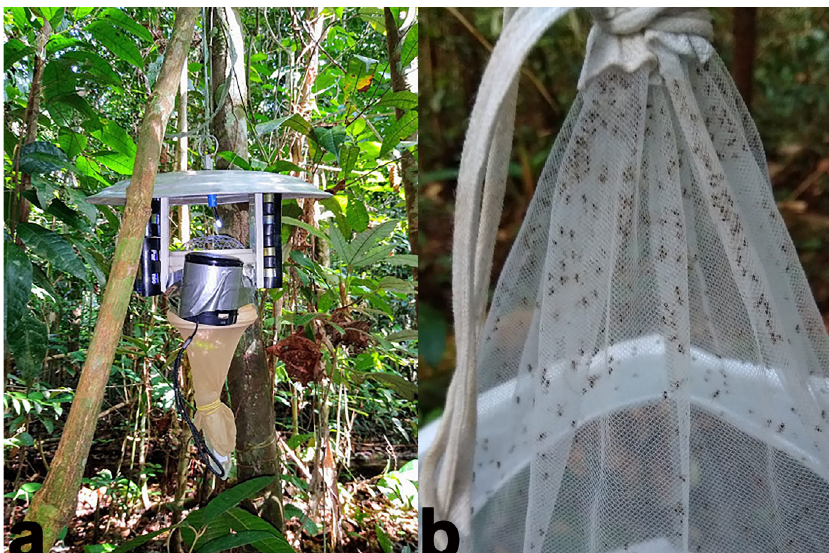
Fig. 2. Method of Corethrella collection. a . CDC light trap with a speaker attached playing looping of frog species songs from the ‘sapoteca’ frog library (https://ppbio.inpa.gov.br/sapoteca/paginainicial). b . Cage with dozens of Corethrella